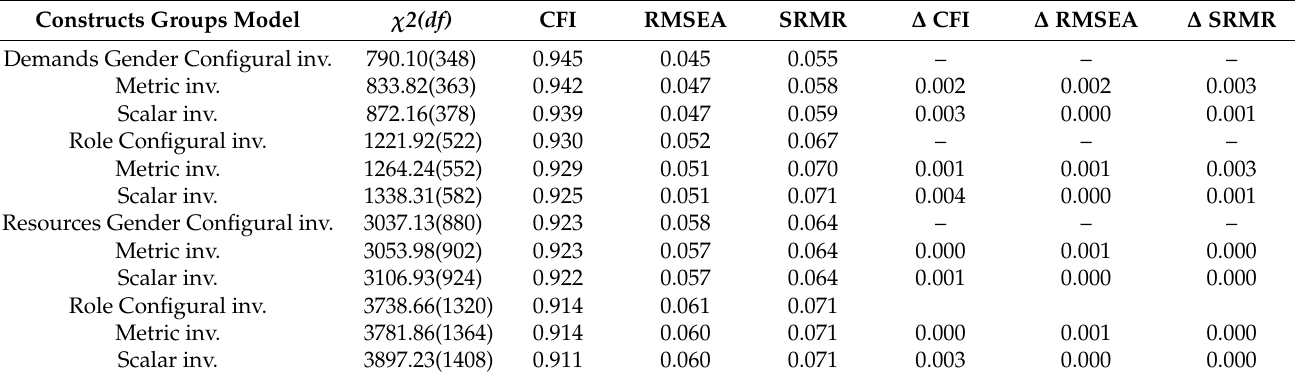
Table 6. Results of invariance analyses for demands and resources across gender (male, female) and across academic roles (researcher, associate professor, full professor).